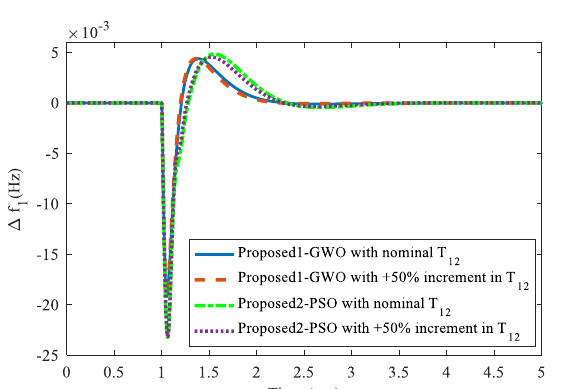
Fig. 22 Frequency deviation in area 1 for case 5e under case study 5